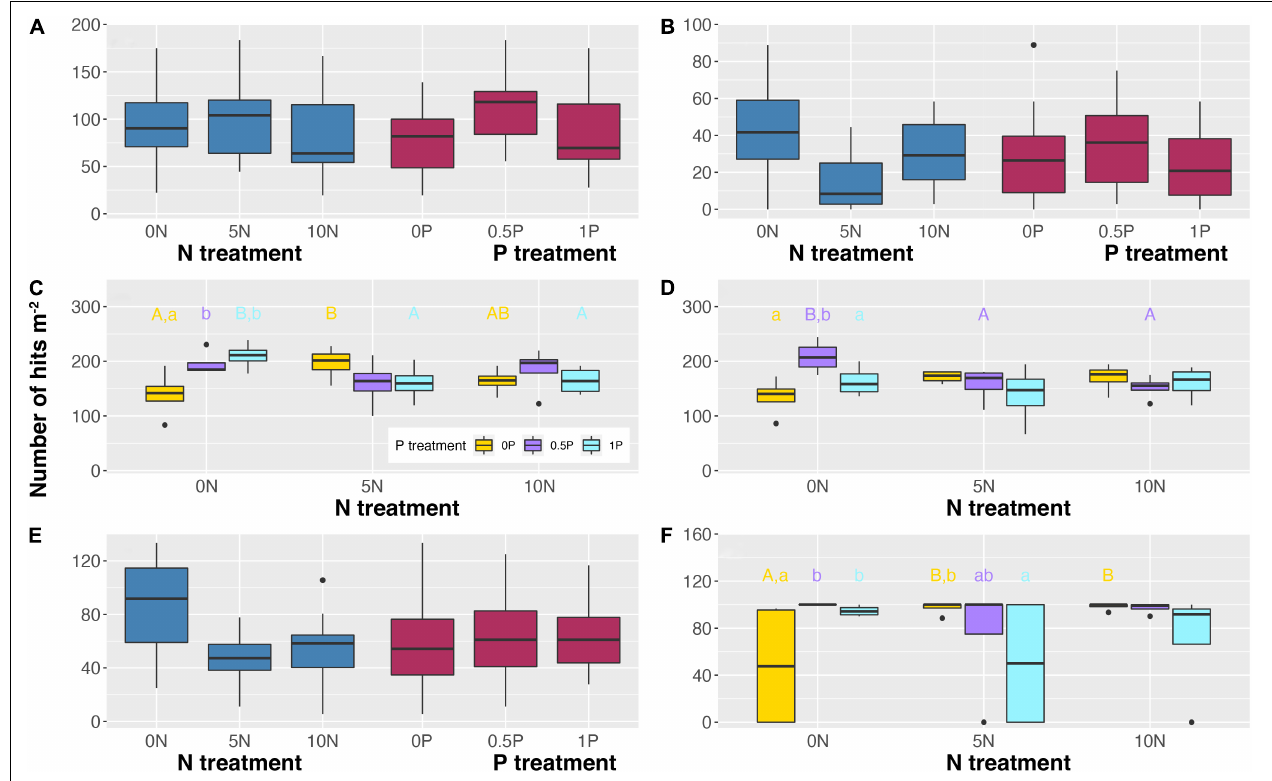
FIGURE 3 | Abundance of ericaceous shrubs (A) , ectomycorrhizal plants (B) , arbuscular mycorrhizal plants (C) , graminoids (D) , deciduous shrubs (E) , and cover of Sphagnum (F) in response to short-term N and/or P additions. When the interactive effect is not significant (A,B,E) , only the main effects are shown. Different uppercase letters represent significant differences ( P < 0.05) among N treatments under the same P addition level. Different lowercase letters represent significant differences ( P < 0.05) among P treatments under the same N addition level. Treatment abbreviations as described in “Materials and Methods” section.